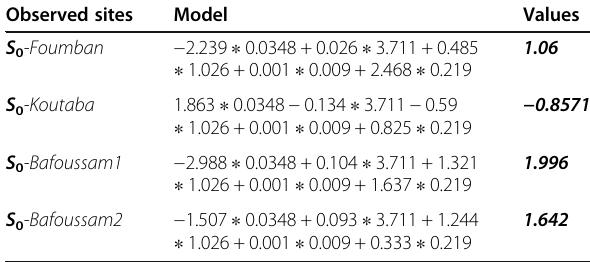
Table 9 Observed sites kriging equations and